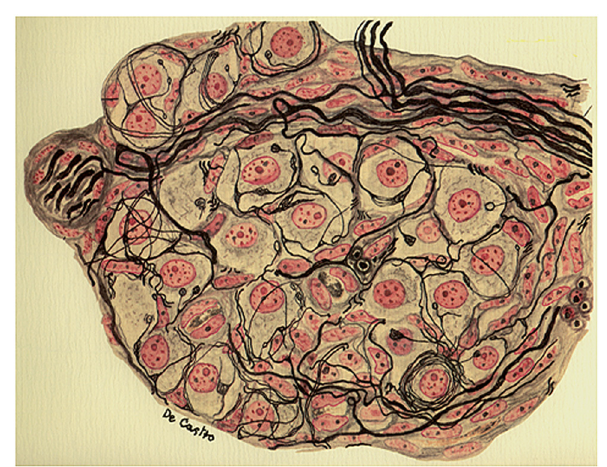
FIGURE 3 | Section from the intercarotid gland (the CB) of an adult cat 25 days after the surgical removal of the vertebral sympathetic chain. The image evidences fascicles of myelinated nerve fibers and parenchymatous cells normally innervated.The preparation was stained by the Cajal’s reduced silver nitrate method and counterstained by the carmine method of Mayer (in de Castro, 1926, 1928, 1951; courtesy of Fernando-Guillermo de Castro from the Archive Fernando de